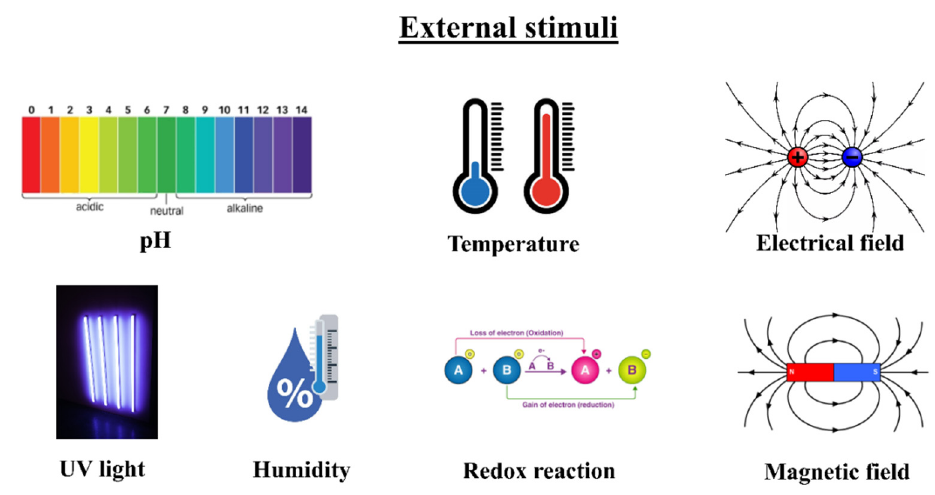
Figure 1. External stimuli for activation of polymer actuators.